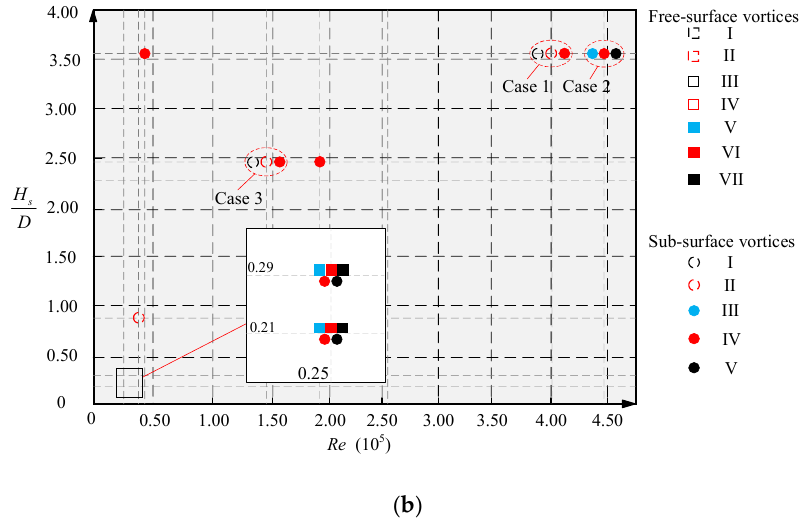
Figure 5. Distributions of vortices in the pump intake of the underground pumping station. ( a ) Vortex patterns in the primary pump intake. ( b ) Vortex patterns in the secondary pump intake.